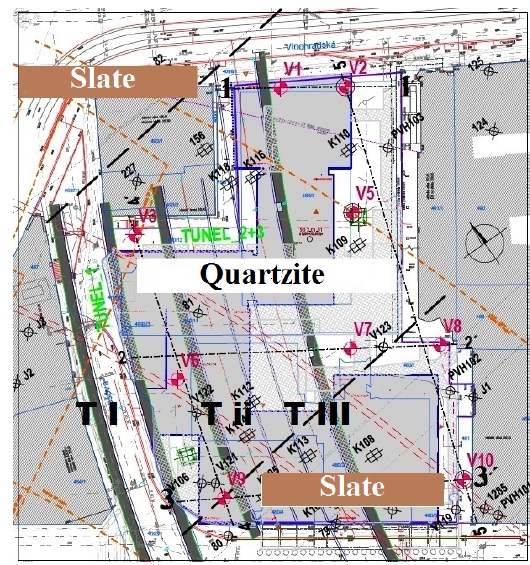
Figure 5. Distribution of rock types encountered in the area of interest ([4] – modified).